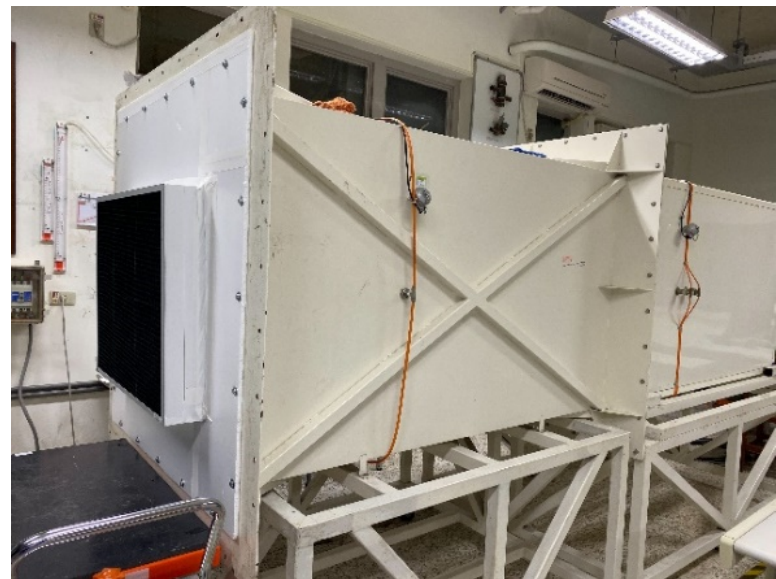
Figure 12. Experiment filter wind tunnel setup.